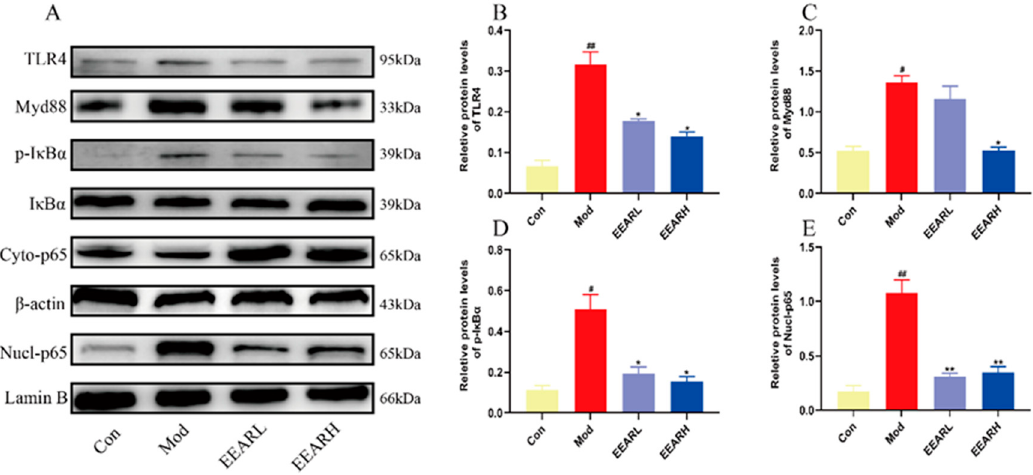
Figure 8. EEAR inhibited LPS-induced activation of the TLR4/NF- κ B signaling pathway in THP-1 cells ( n = 3). ( A ) TLR4/NF- κ B signaling pathway expression levels in cells as measured by Western blot analysis. ( B ) Quantitative analysis of differences in TLR4 levels in each group. ( C ) Quantitative analysis of differences in Myd88 levels in each group. ( D ) Quantitative analysis of differences in P-I κ B α levels in each group. ( E ) Quantitative analysis of differences in nuclear p65 levels in each group. ## p < 0.01 vs. Control; # p < 0.05 vs. Control; ** p < 0.01 vs. Model; * p < 0.05 vs. Model.